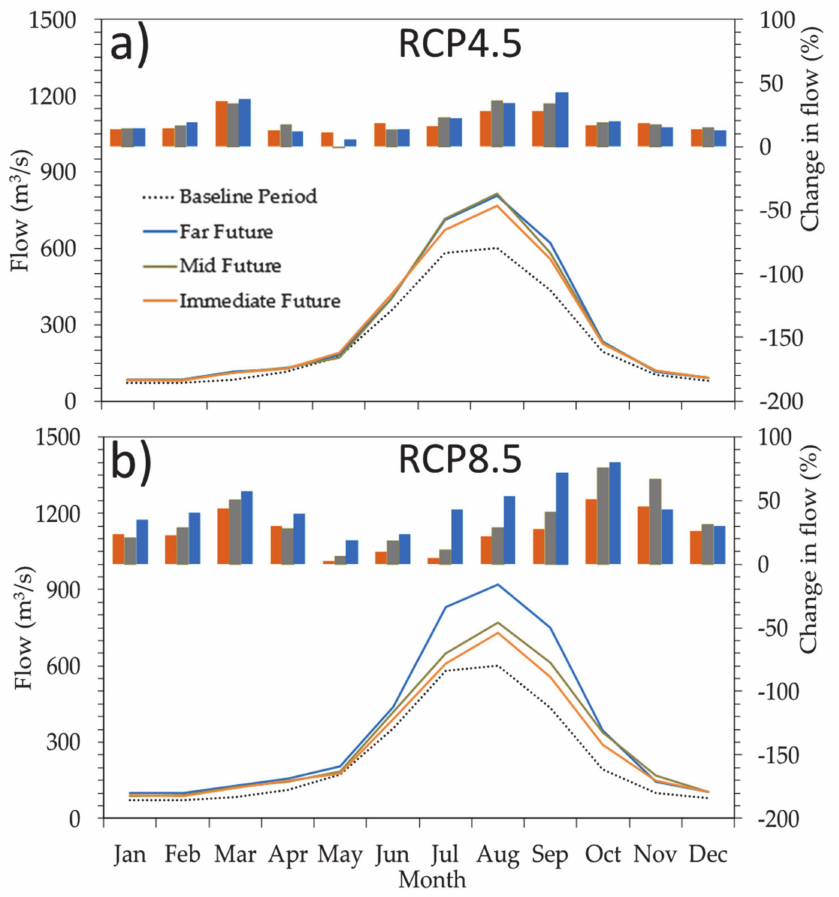
Figure 7. Hydrographs of monthly ensembled and baseline flows and their changes; ( a : RCP 4.5 and b : RCP 8.5) black dashed (baseline), red (Immediate Future—IF), grey (Mid Future—MF), and blue (Far